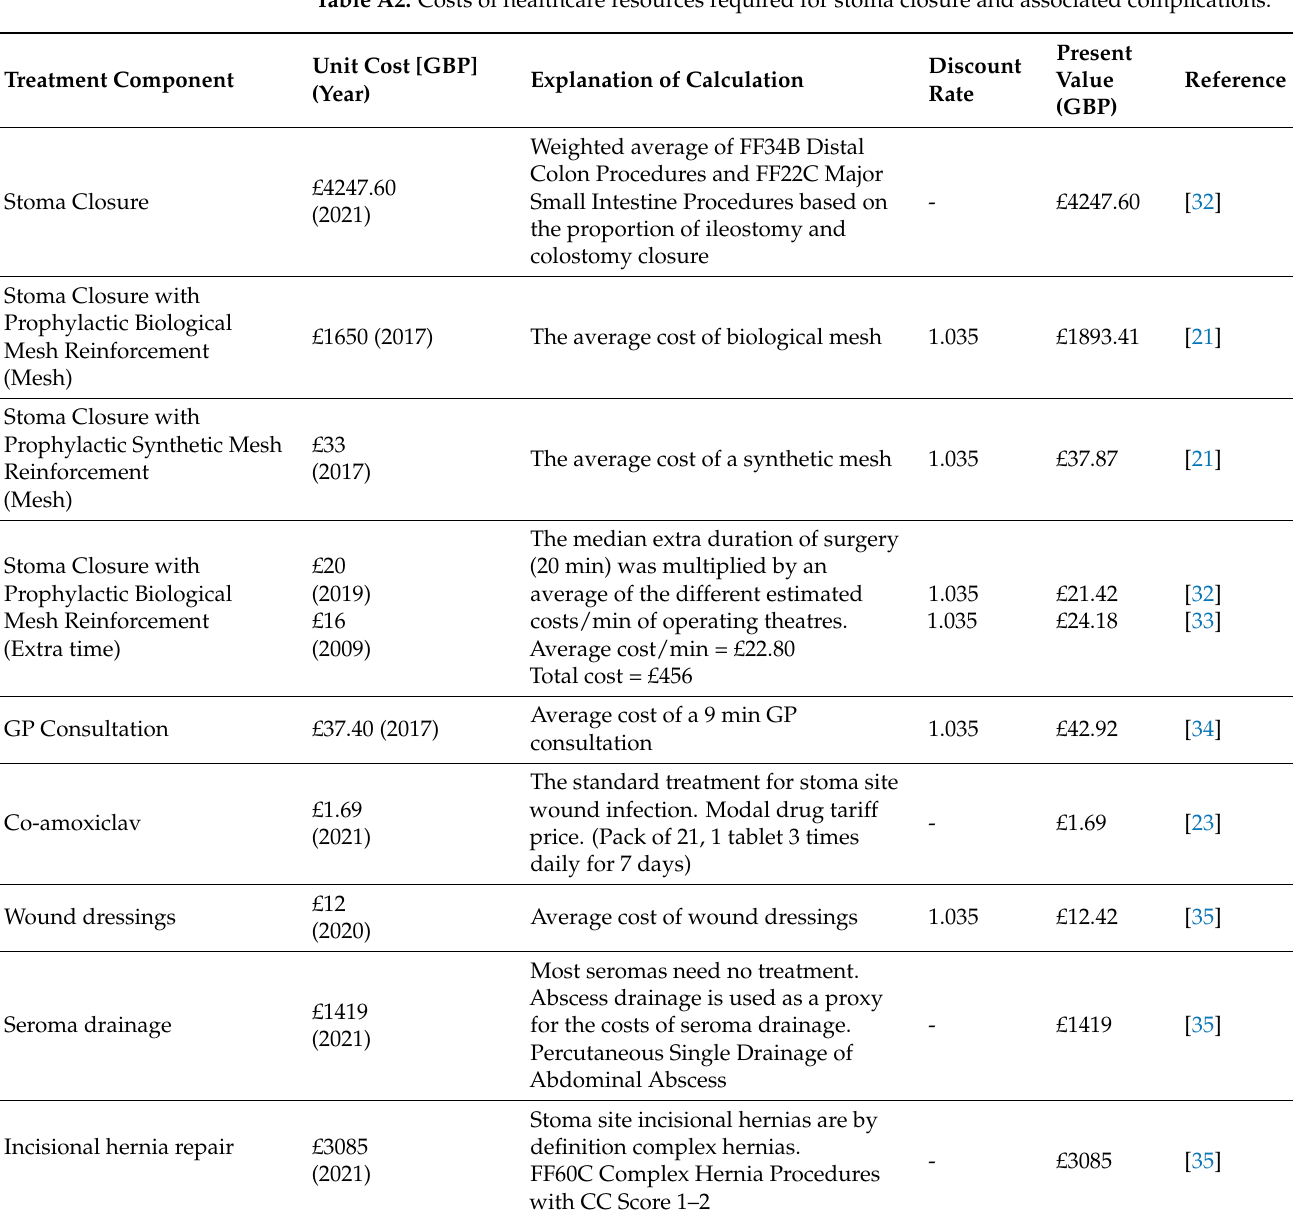
Table A2. Costs of healthcare resources required for stoma closure and associated